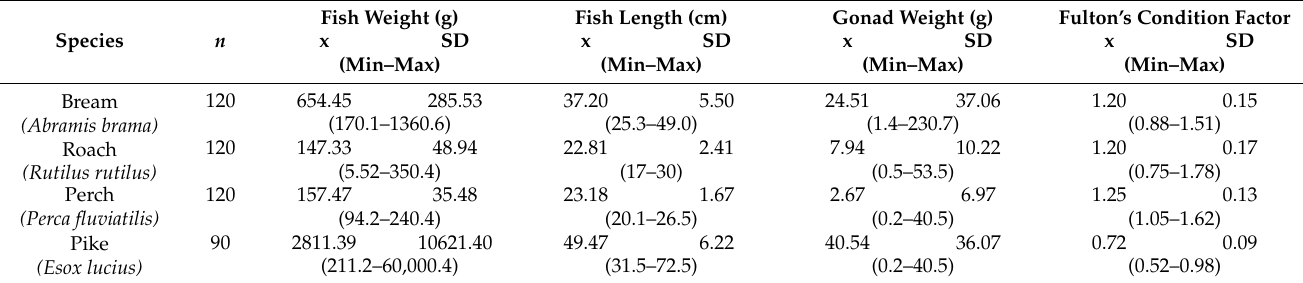
Table 1. Biometric measurements of the fishes